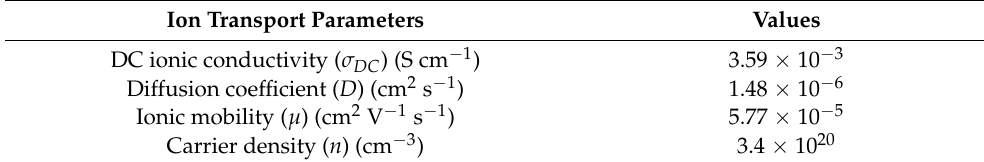
Table 2. Various ion transport values for the produced composite polymer